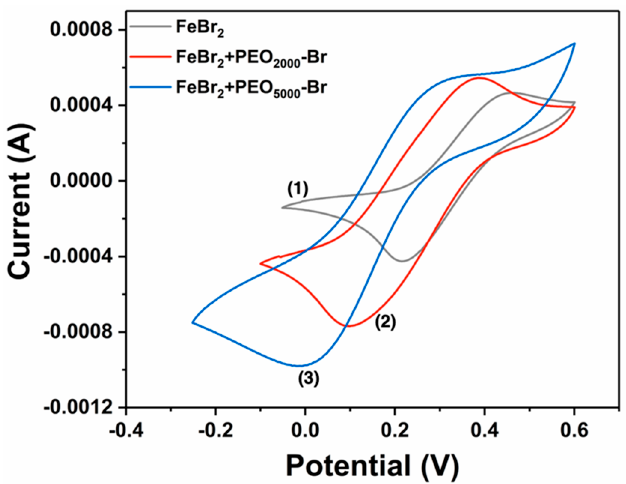
Figure 2. Cyclic voltammetry (CV) curves of 10 mM FeBr 2 with different additives: ( 1 ) No additive; ( 2 ) 5 mM PEO 2000 -Br; ( 3 ) 5 mM PEO 5000 -Br under the electrolyte solution of 0.1 M Et 4 NBF 4 in MeCN, recorded at a scan rate (V) of 50 mV s − 1 .